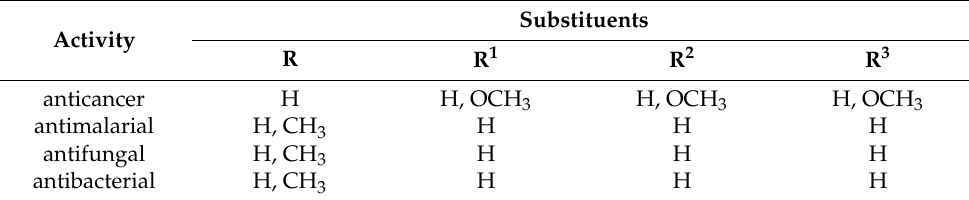
Table 1. The dependence of the activity of alkaloids 92 – 96 on the types of substituents.